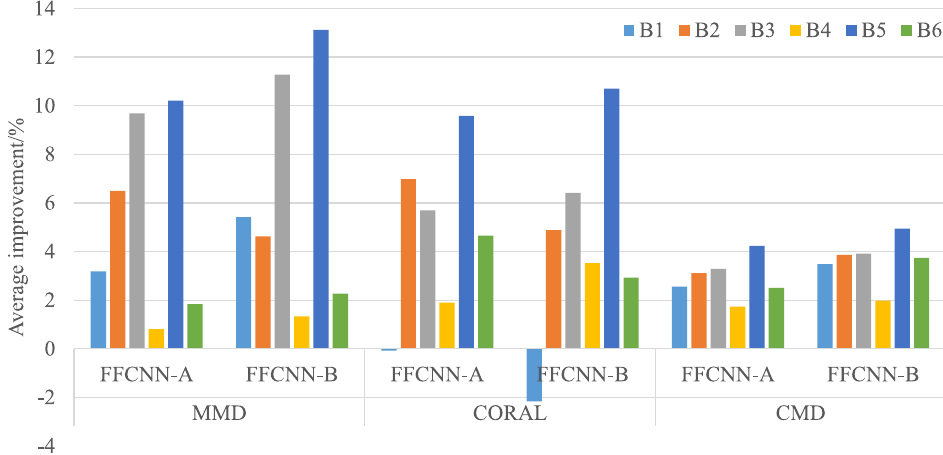
Figure 7. Average improvement of CWRU dataset.